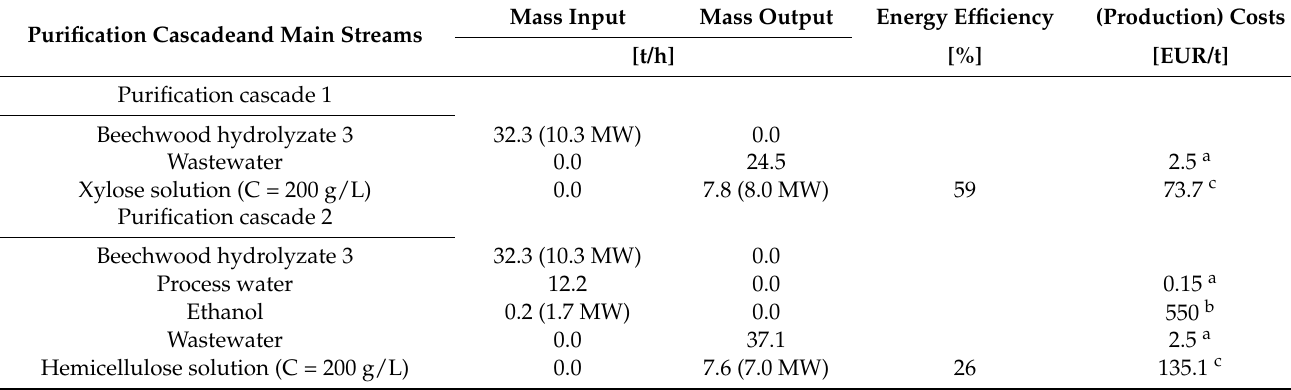
Table 4. Mass balance, energy efficiency, and (production) costs of purification cascades 1 and 2 (assumed capacity: 258,400 metric tons of BWH 3